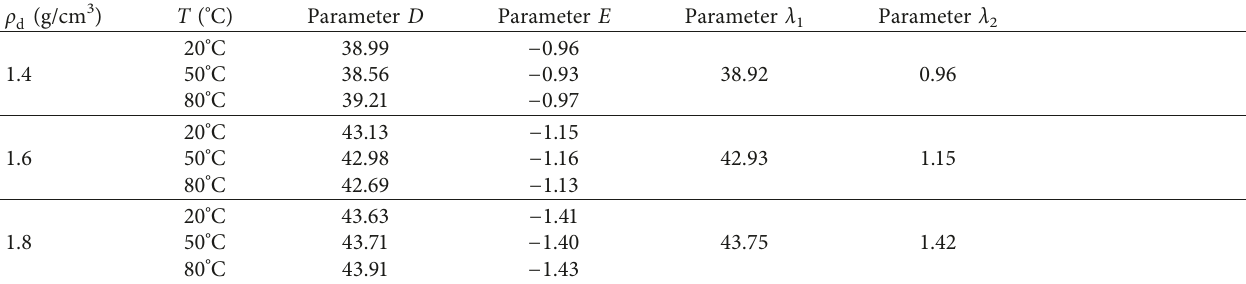
Figure 9: The relationship of internal friction angle and water content of samples under the dry density of 1.4 g/cm 3 . Table 7: The parameters’ value under different dry densities and